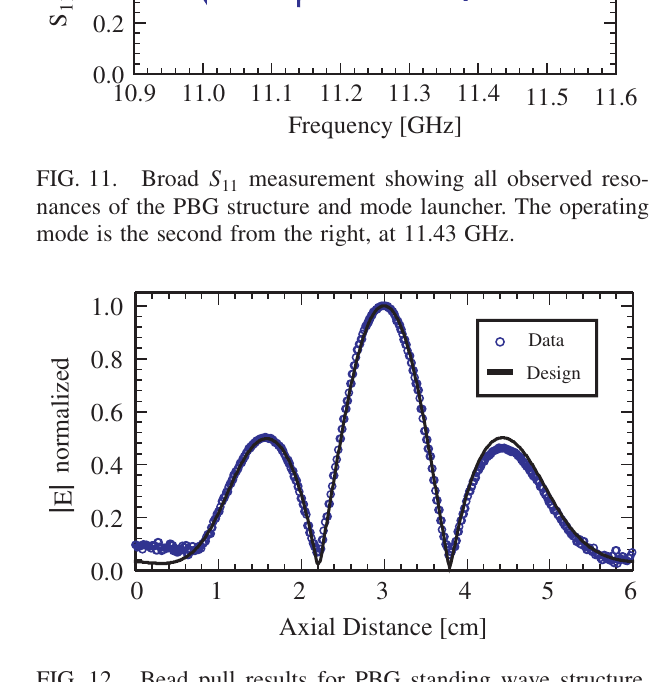
FIG. 12. Bead pull results for PBG standing wave structure. Very good agreement is seen between the cold test bead pull measurements and the design